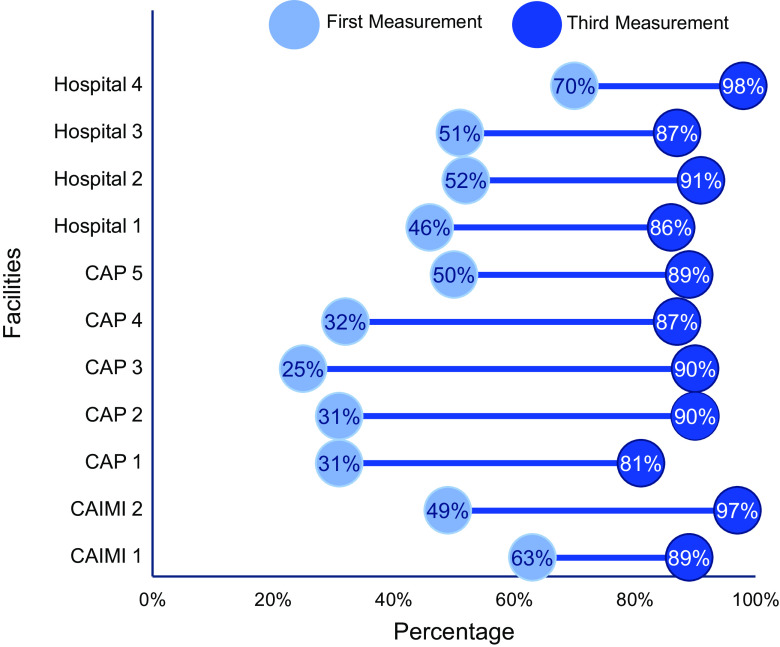
Baseline and End Line Assessment of Overall Compliance Level of Clean Clinic Assessment Criteria Before and After Clean Clinic Approach Intervention, by Facility (N=11)